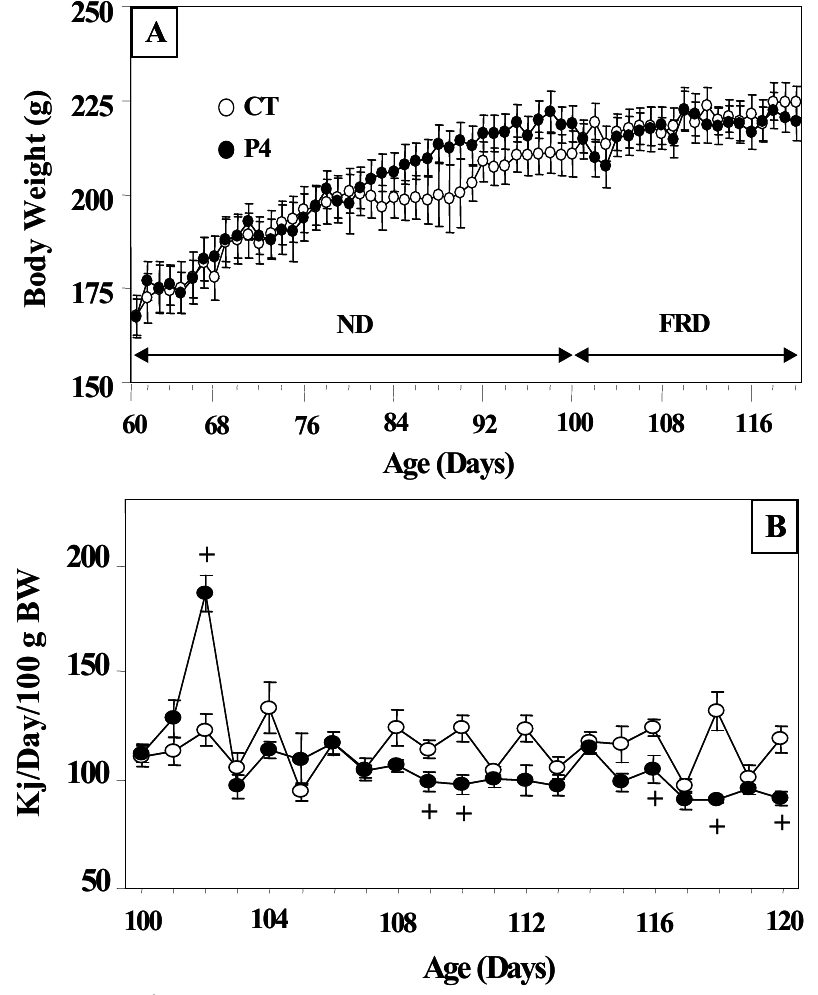
Figure 1. Daily body weight ( A ) values in control (CT) and P4-treated rats fed a